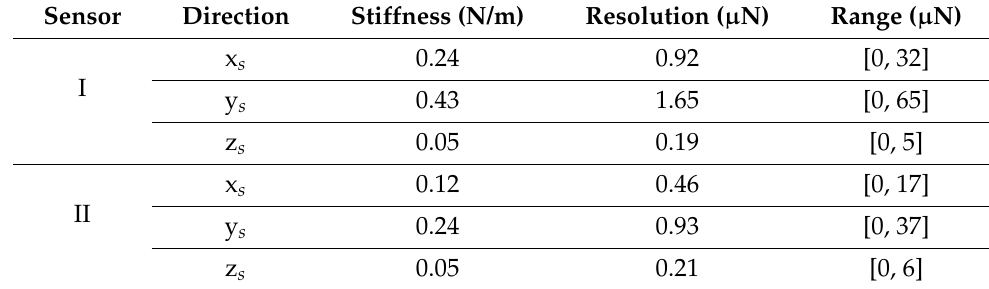
Table 1. Properties of the µ